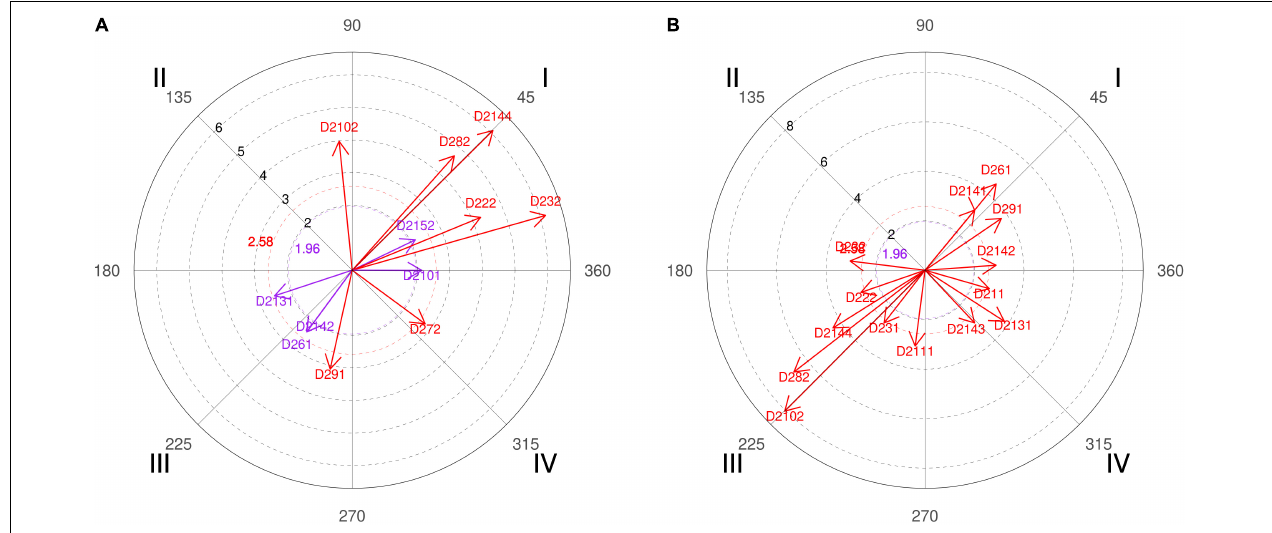
FIGURE 11 | (A,B) Relationship of conditioned behaviors that present a significant relationship with the focal behaviors “favorable evaluation” and “unfavorable evaluation” analyzing question 16 of the in-depth interviews. In “favorable evaluation,” a total of 12 significant vectors were detected, and in “unfavorable evaluation,” a total of 14 significant vectors were